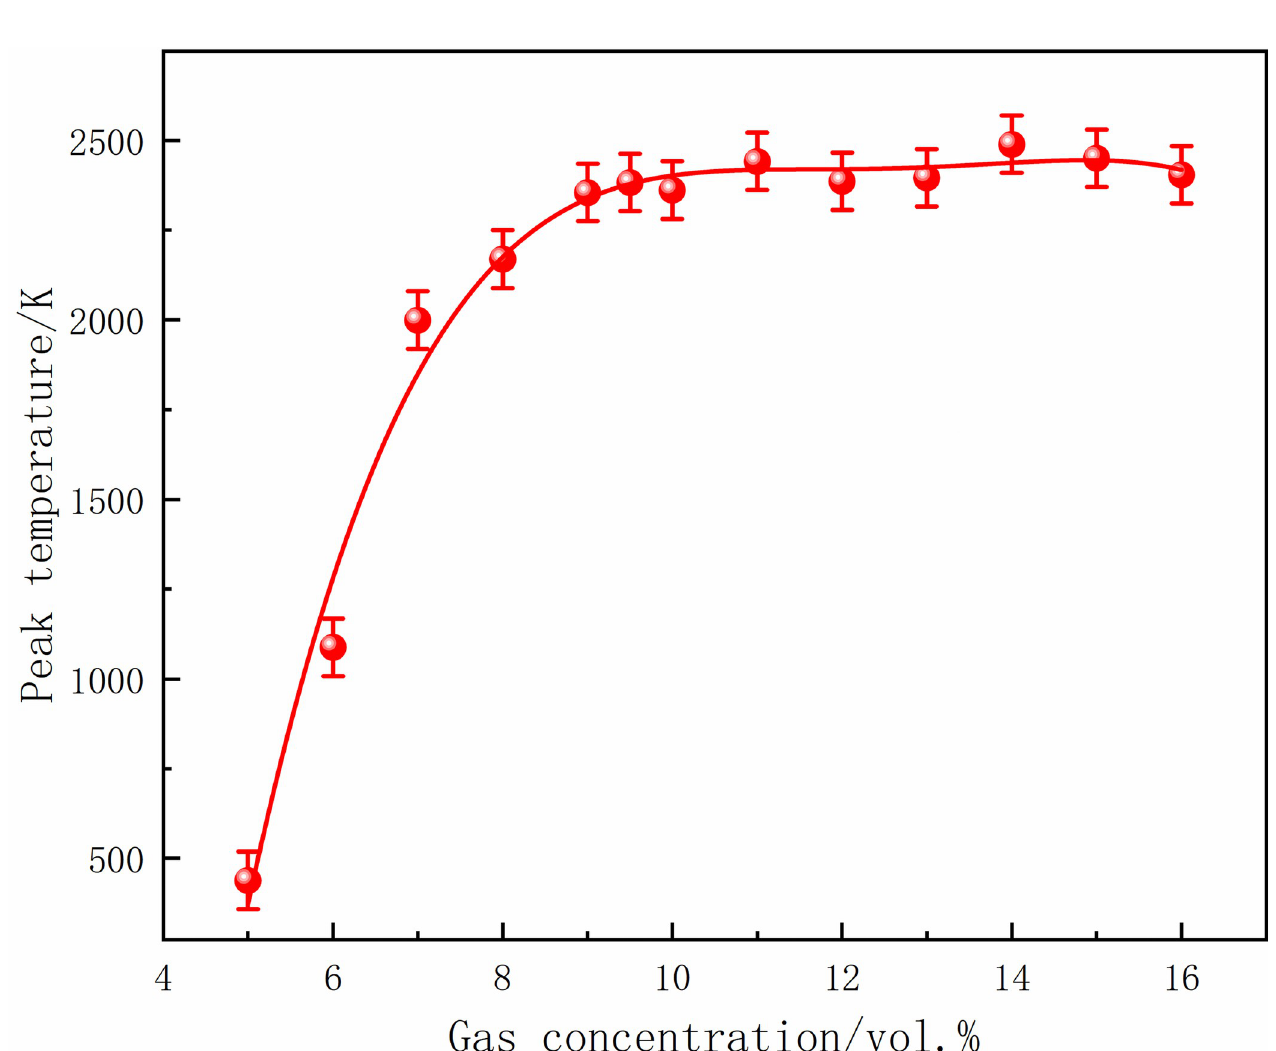
Fig 26. Temperature peaks at different local gas concentrations at the monitoring point 5.